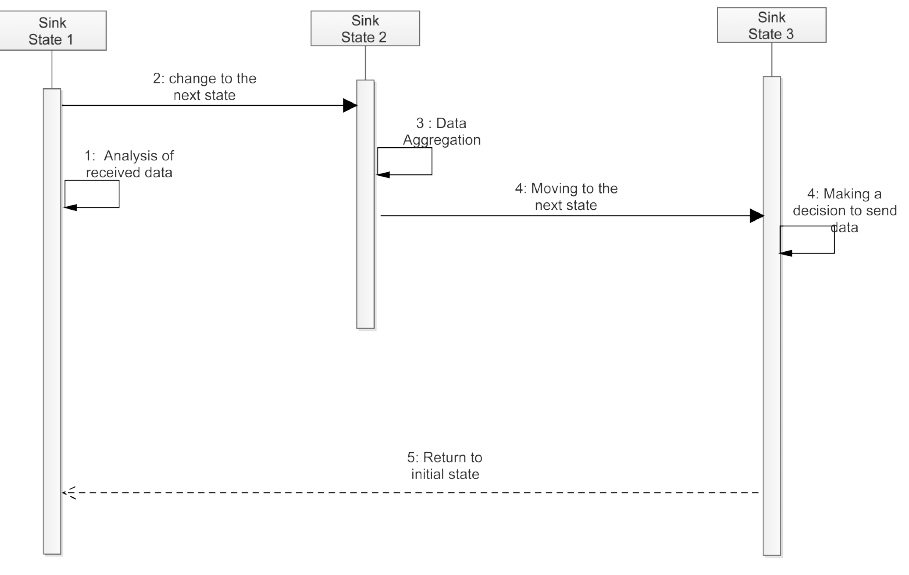
Figure 8. Sink Activity Sequence